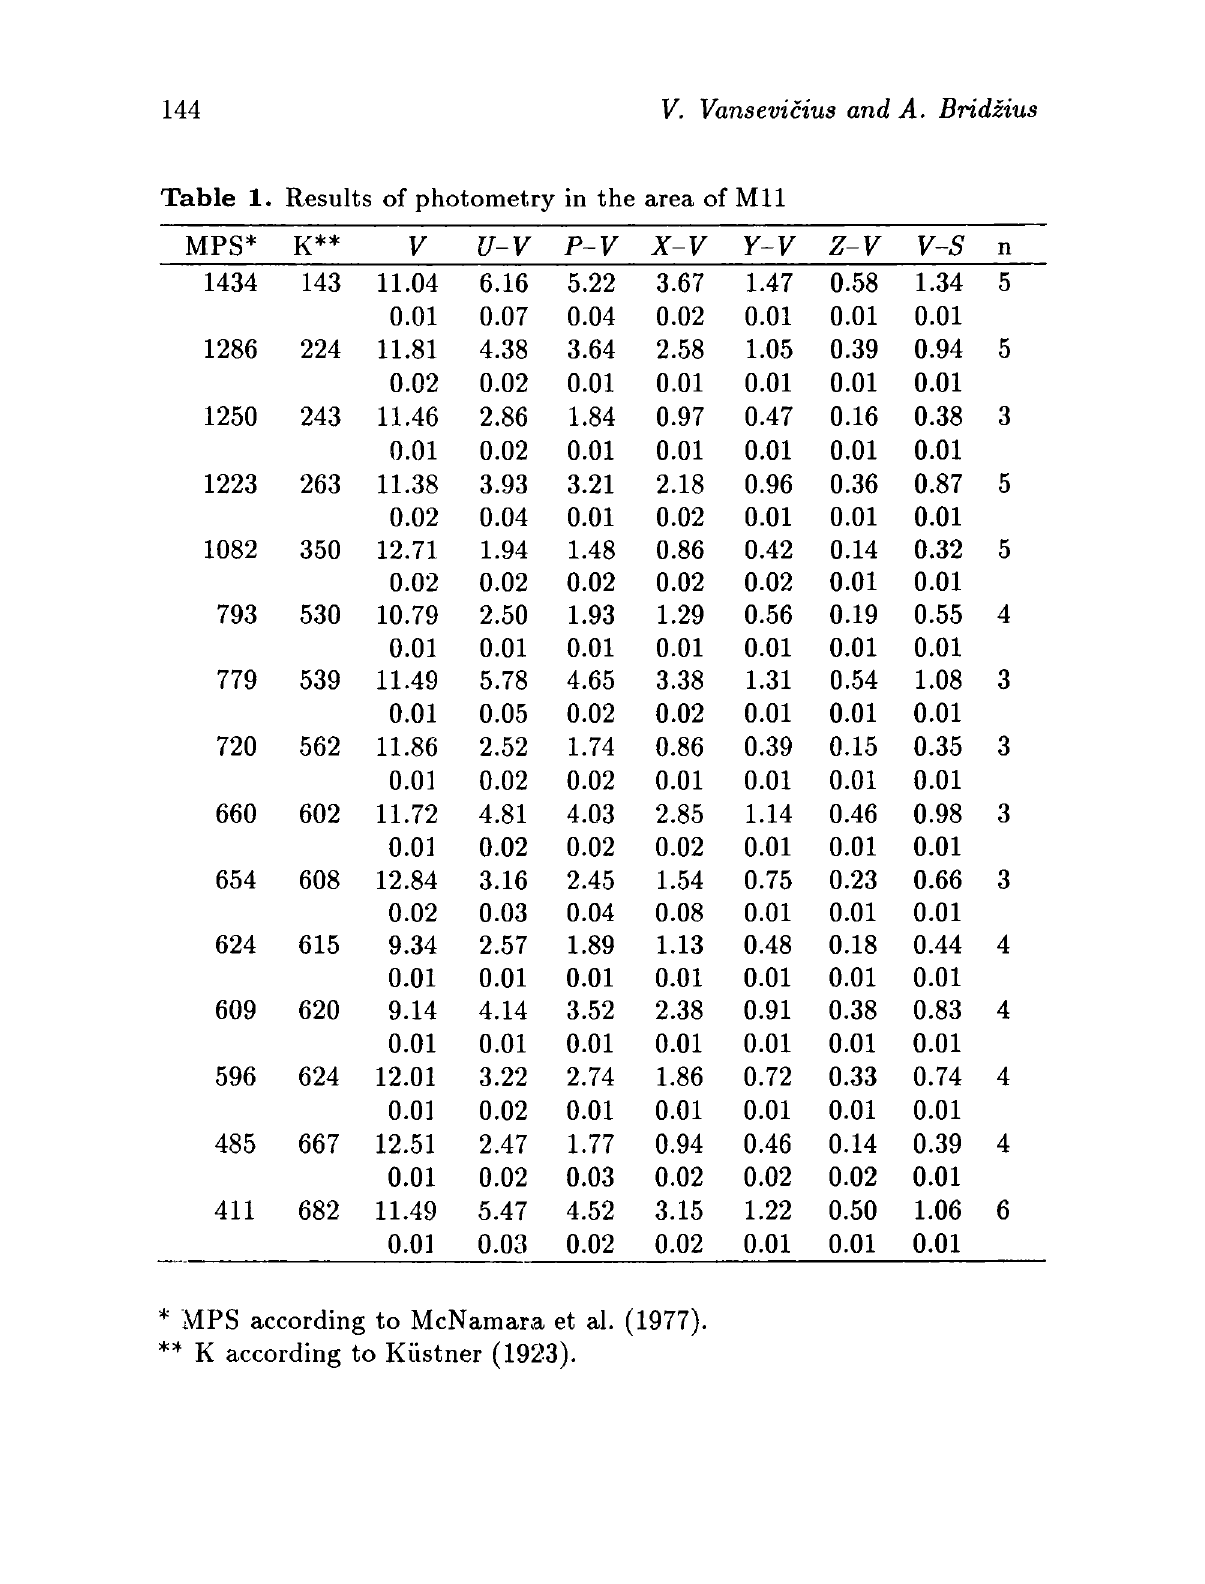
Table 1. Results of photometry in the area of M